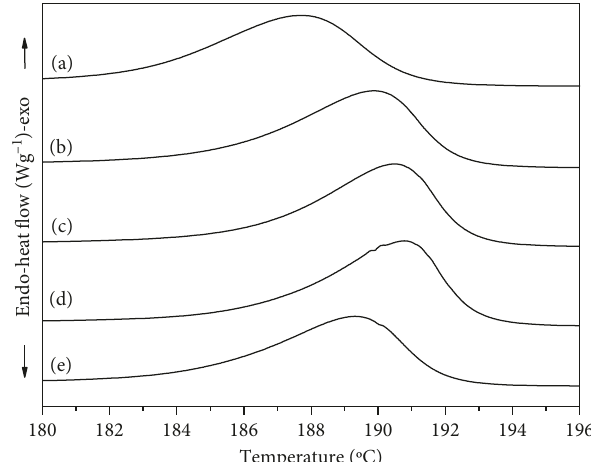
Figure 5: Exothermic thermograms of the nylon 6 (a) and the nanocomposites at concentrations of 0.01 (b), 0.05 (c), 0.10 (d), and 0.50 (e)